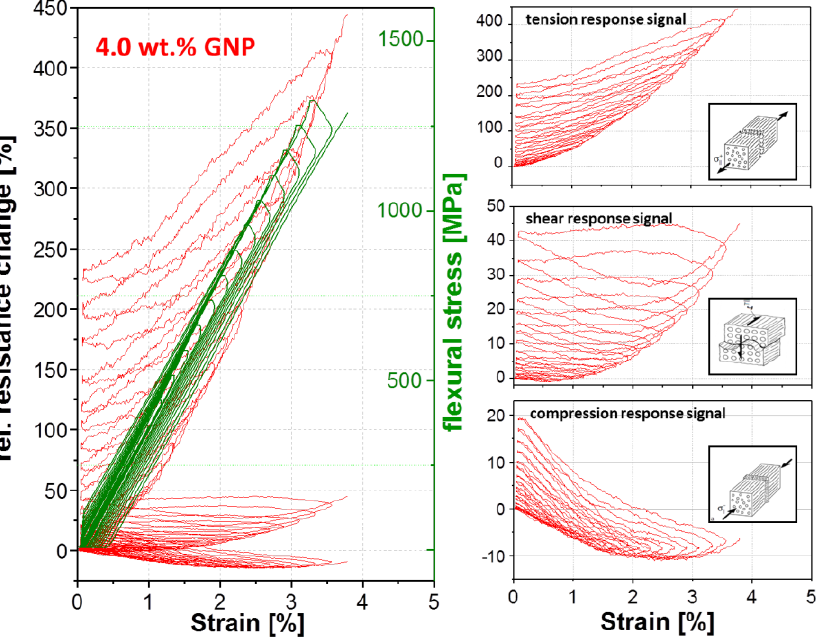
Figure 10. Cyclic electromechanical response behavior of nanostructured sensor fiber using 4 wt. % GNP embed in the planes of maximum stresses for compression, shear and tension, during a quasi-static three-point bending (Span to Length L/h ratio of 33, a stepwise increase of a mechanical loading of 50 MPa).